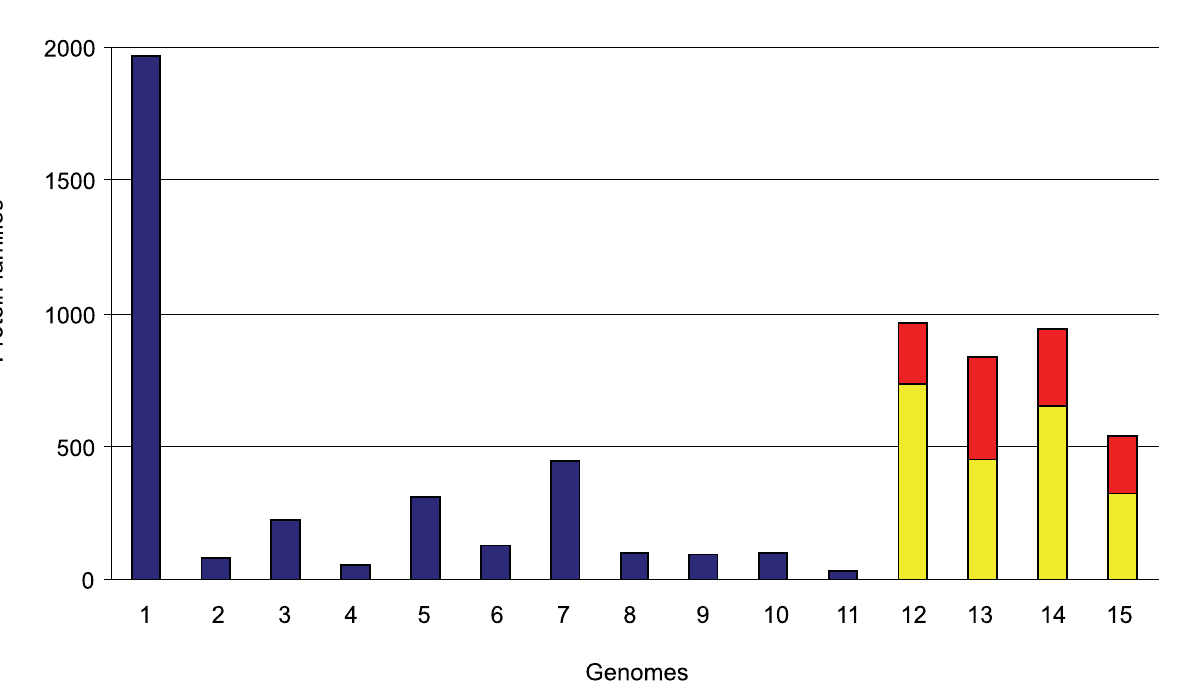
Figure 1. Distribution of protein families in the genomes of S.meliloti (S), A.tumefaciens (A), R.leguminosarum (L) and R.etli (E). - Bar number indicates the assignation of the protein families to the corresponding genome according to the following letters code: 1, SALE; 2, SAL; 3, ALE; 4, SAE; 5, SLE; 6. SA; 7, LE; 8, AL; 9, SE; 10, SL; 11, AE; 12, S; 13, A; 14, L; 15, E. Bars 12-15 show in red the proportion of orphan genes compared with those which match with known or hypothetical proteins present in the nr database of Genbank